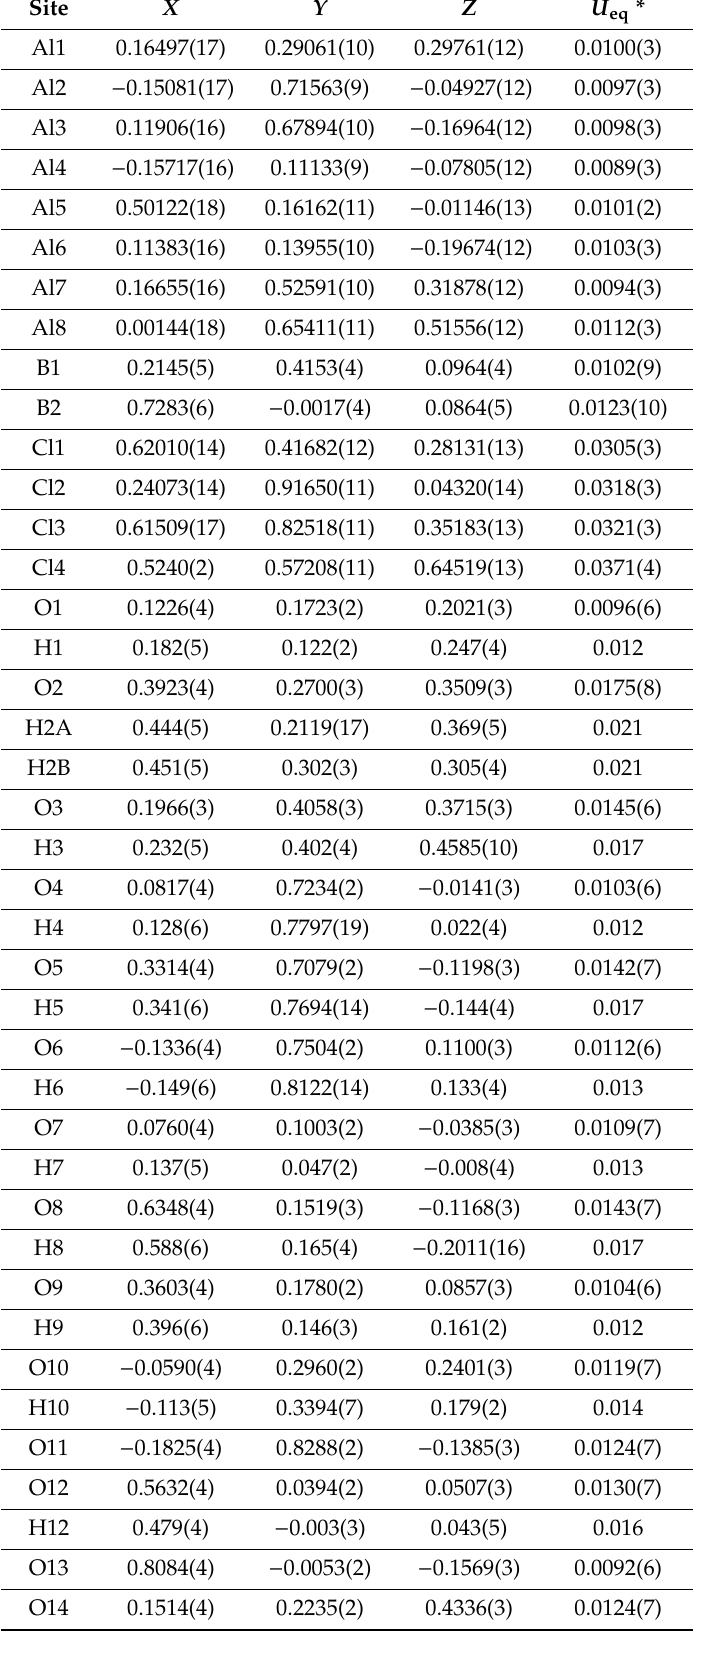
Table 3. Coordinates and equivalent displacement parameters ( U eq , in Å 2 ) of atoms in